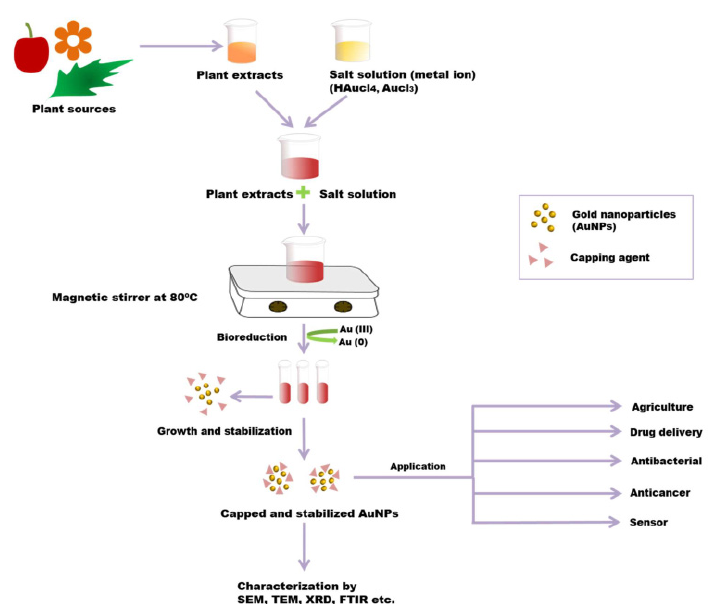
Figure 5. Plant-mediated synthesis of Au nanoparticles and their characterization. Copied from MDPI [79].